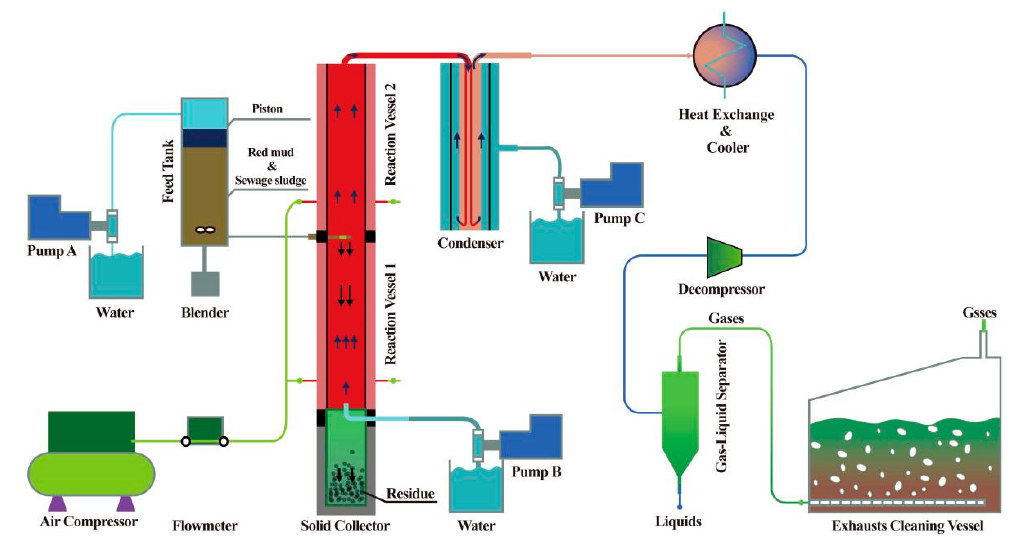
Figure 6. Supercritical water oxidation system for sewage sludge treatment using red mud. Reproduced with permission from [81], published by Elsevier Ltd., 2016.